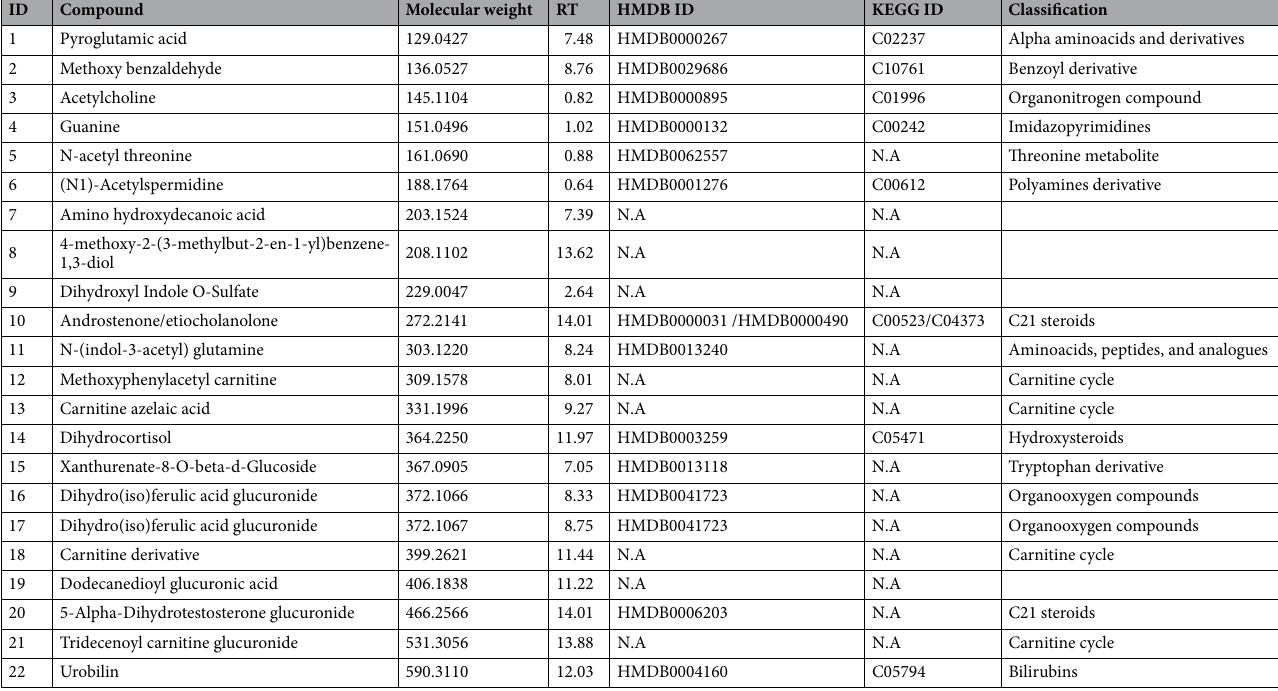
Table 1. List of ESI + metabolites, together with their MW, chromatographic retention time, Kegg and HMDB IDs and NMDB classification, when